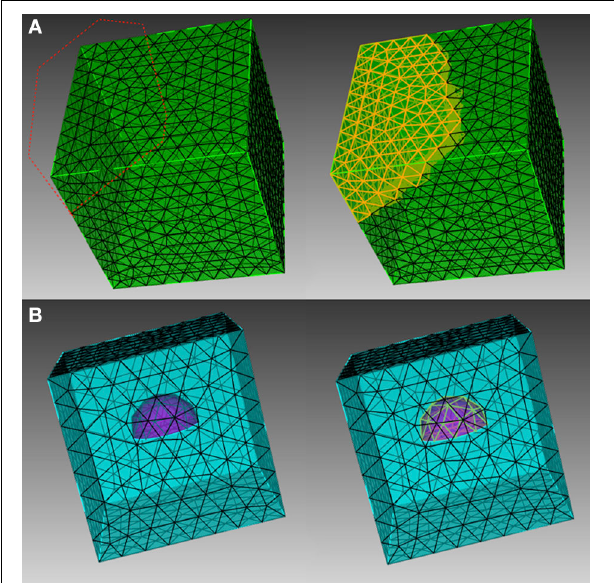
FIGURE 1 | Different element selection methods in CUBIT. (A) Direct range selection of elements. Elements within the red dot line range are selected. (B) Indirect bounding object selection. Elements within the purple hemisphere are